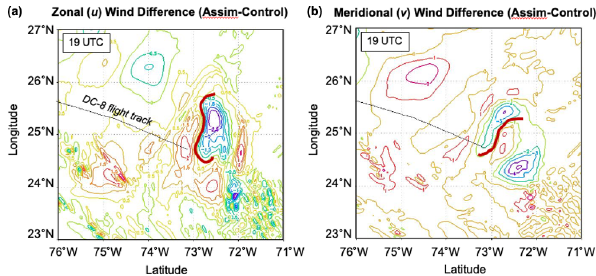
Figure 15. Thermodynamic increments (assimilation minus con- trol) that resulted after the first DAWN assimilation period centered at 19:00UTC. (a) Water vapor mixing ratio difference (kgkg − 1 ). (b) Potential temperature difference in Kelvin. The shaded red area denotes the area of the highest contour levels (strongest positive increments) in the vicinity of where the subsequent precipitation developed in the assimilation run. The DC-8 flight segment during this time is